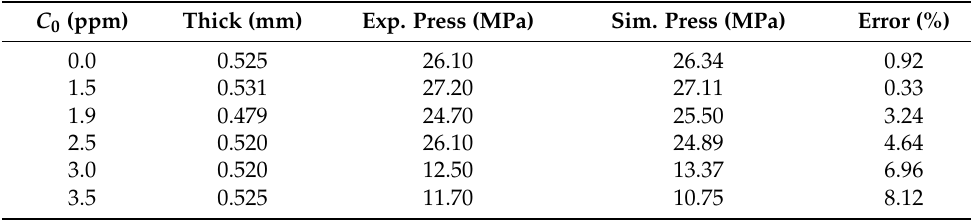
Table 3. Comparison between simulation and test for Case 4.